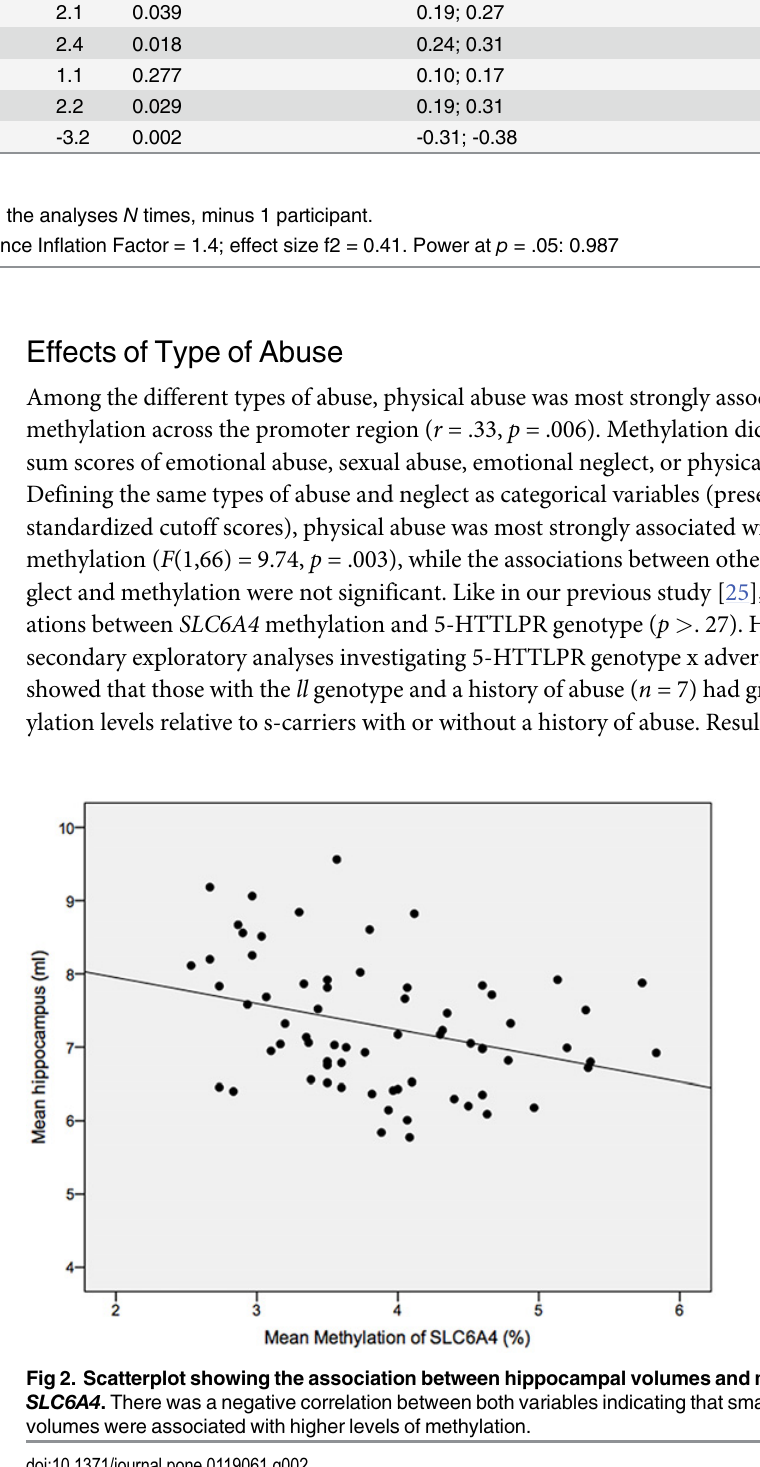
Table 2. Parameters of the investigated regression model that includes sex, age, MDD diagnosis, childhood abuse, and hippocampal volume as independent variables, and SLC6A4 methylation as the outcome variable. Statistical Model